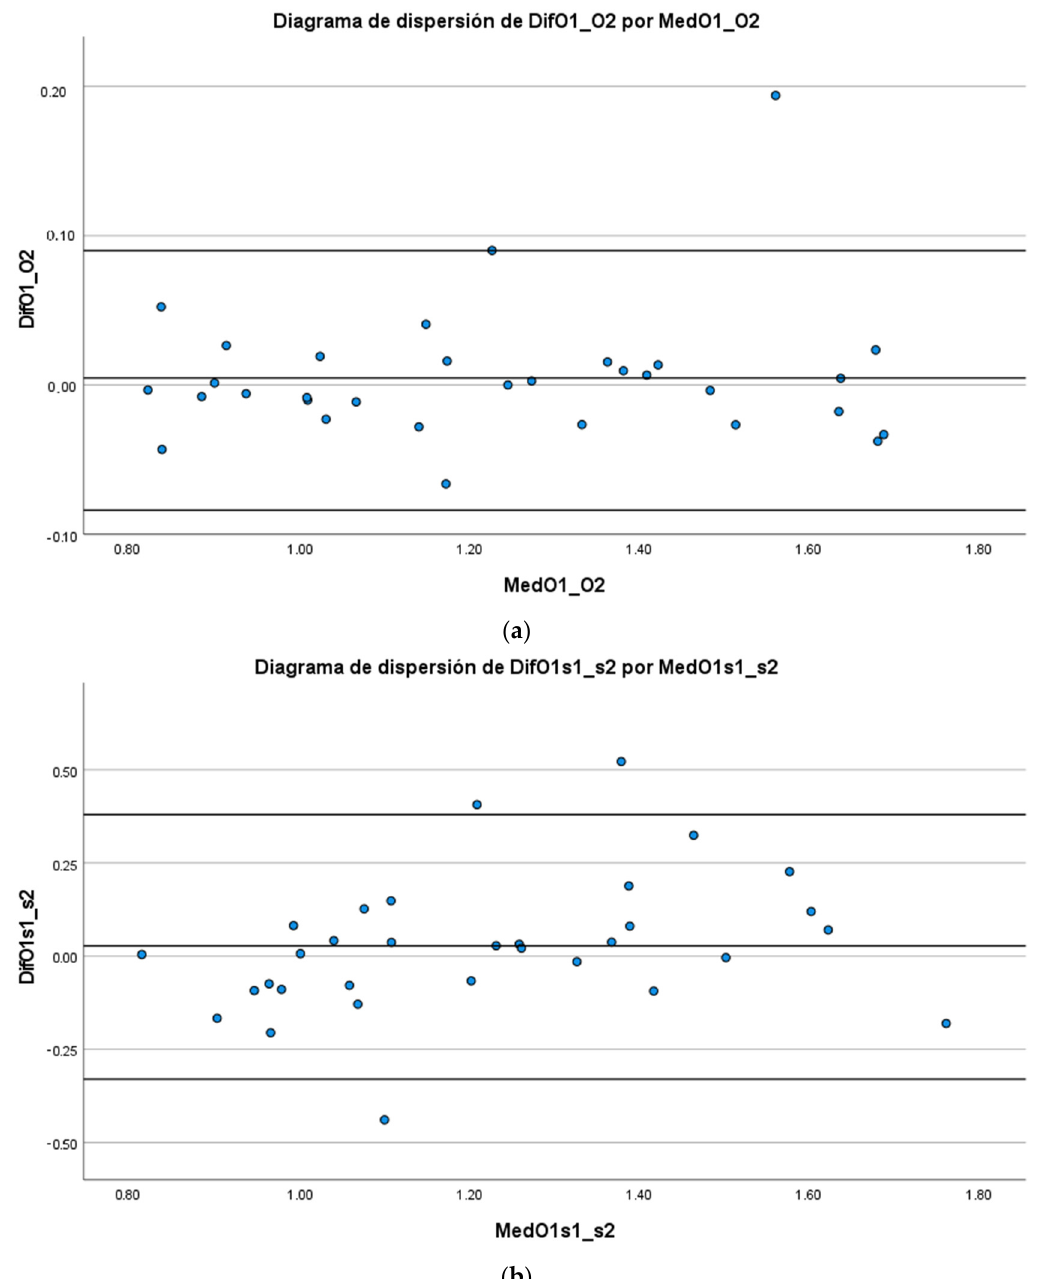
Figure 1. Bland-Altman plots. ( a ) Intra-rater reliability; ( b ) Inter-rater reliability; The bias and limits of agreement (black lines) are displayed for 10MWT (seconds) measurements. The mean score is represented on the x-axis and the difference between sessions (mean of the differences) is represented on the y-axis (mean di ff erence ± 1.96 SD).